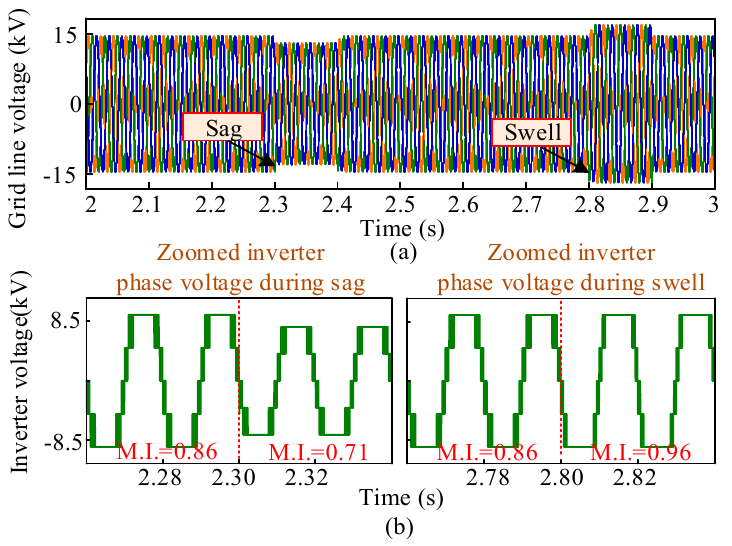
Figure 15. Voltage sag/swell response: ( a ) grid line voltage and ( b ) zoomed inverter phase